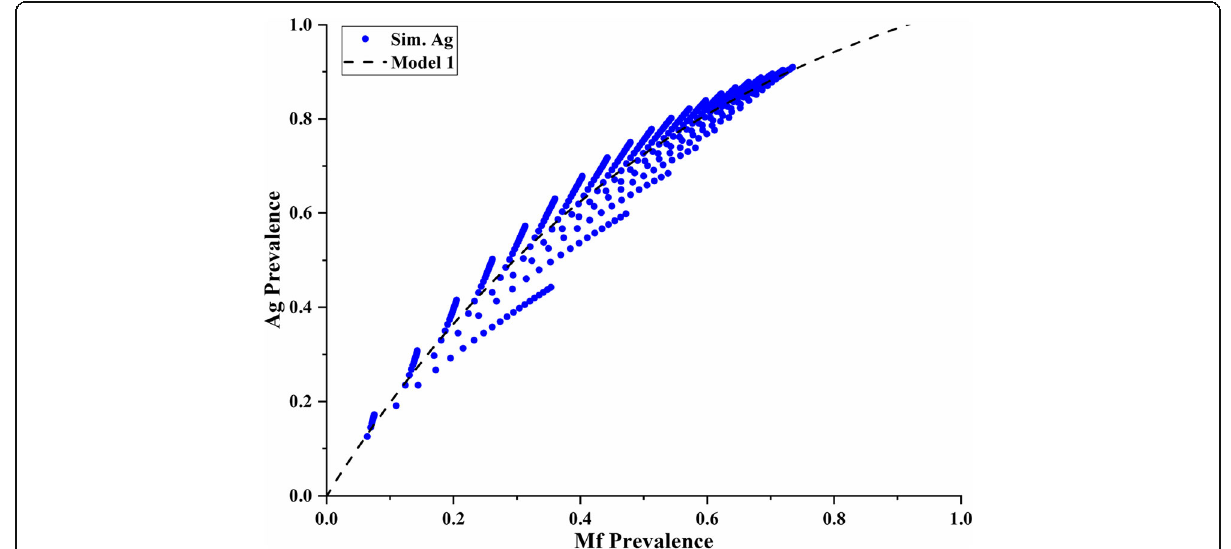
Fig. 6 Graph showing the relationship between Mf and antigen prevalence values based on calculations using the model suggested by Irvine et al. [26]. Our parameters ’ assumptions were alpha = 0.50 (production rate of mf), m (0.2 – 4.0), kw (0.2 – 4.0) and phi (sensitivity,